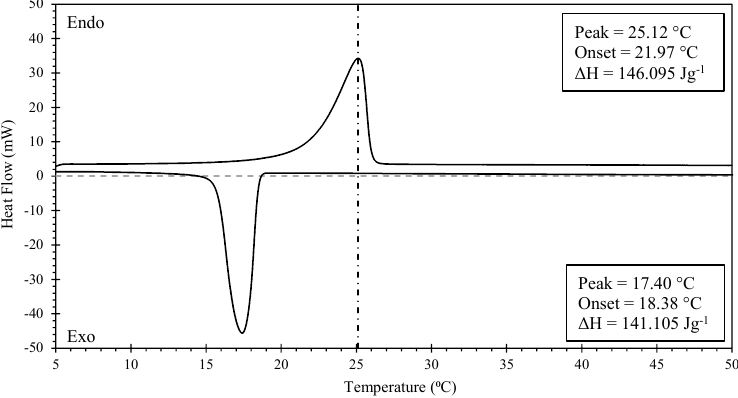
Figure 7. DSC curves for the pure samples of the Rubitherm PCM